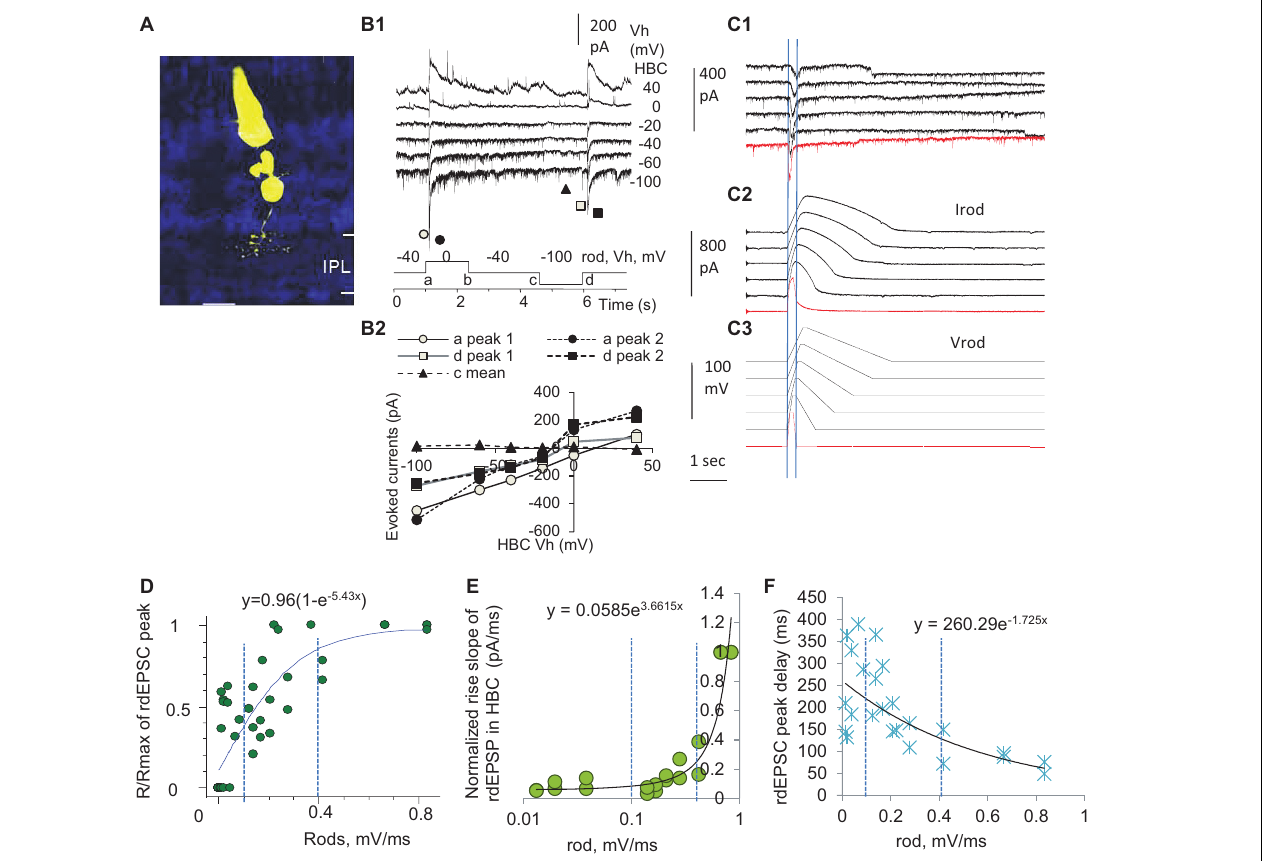
FIGURE 3 | Three zones of presynaptic depolarizing speed differentially determine the delay, duration, and amplitude of the output in the rod-HBC synapse. Rod-HBC pairs (A) were recorded under voltage-clamp mode in dark-adapted conditions, and Vh was − 60 mV for HBCs and − 40 mV for rods. (A) Recorded cells were visualized by Lucifer yellow fluorescence with a confocal microscope. (B1) Rod-driven HBCs show robust spontaneous postsynaptic currents (sPSCs). The HBC responds to the maximum depolarization speed (square waves) with large transient inward cation currents (components a and d) and the maximum hyperpolarization speed with very small outward cation currents (components b and c), demonstrating that the synapse largely favors presynaptic depolarization. sPSCs and the PSCs evoked by stimulating rods reverse near 0 mV (B2) , indicating that the photoreceptor input mediates cation currents in the HBC and the recording is less affected by inhibitory neurons. (C) rods were stimulated by the depolarizing voltage ramps ( − 40 to 20 mV, V rod ) of variable rising and decay slopes, and currents in the rod (I rod ) and rod-driven excitatory postsynaptic currents (rdEPSCs, C1 ) in the HBC are recorded. Two vertical lines in (C1) denote the time to peak of rdEPSCs, which is much shorter and left-shifted compared with that of Vrod and Irod. (D–F) The normalized peak (the response/ maximum response, R/R max , D ), rising slope (E) , and delay (F) of the rdEPSCs were plotted as the function of the rod depolarization speed (mV/ms). (D) The amplitude of rdEPSC is exponentially correlated with the rod depolarization speed ( p < 0.001) and plateaued at ∼ 0.4 mV/ms. (E,F) For the steeper rod depolarization, rdEPSCs rise faster